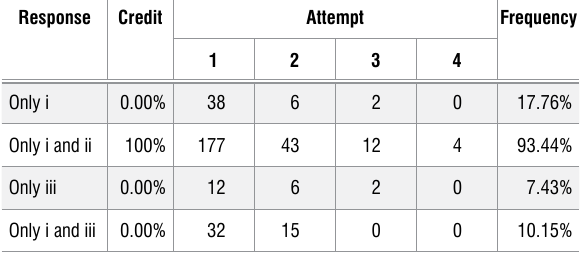
Analysis of student responses for Question 4 ( n = 259) response